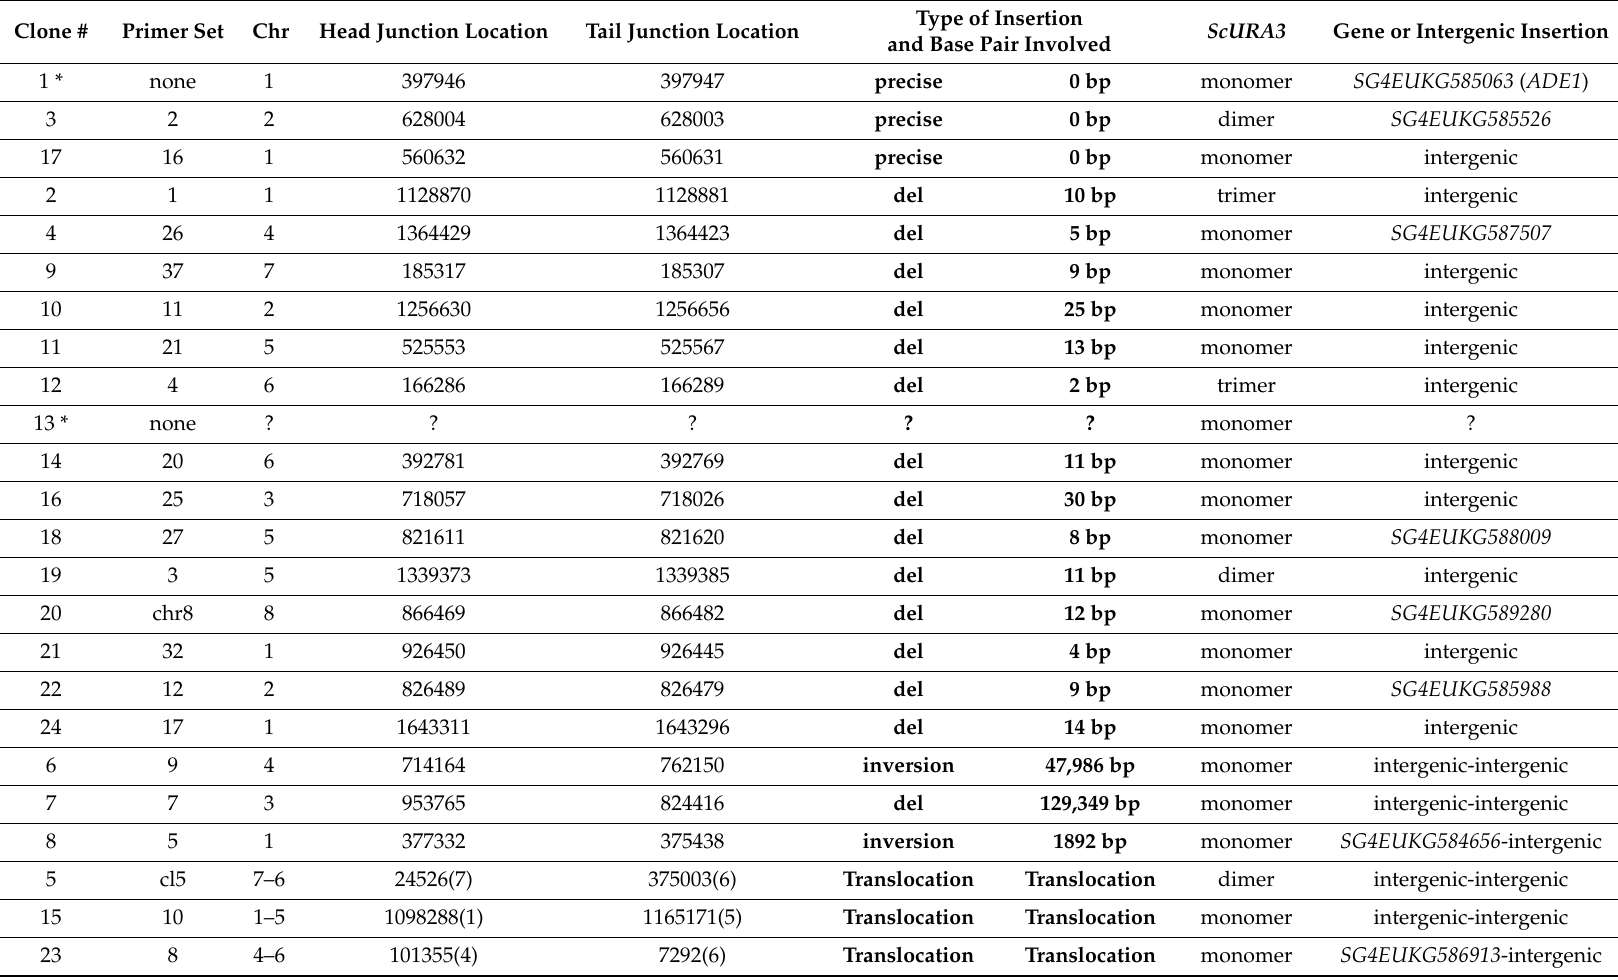
Table 1. Types of ScURA3 insertion events. The asterisk next to clones 1 and 13 indicates incomplete information (see text). Chr: Chromosome. #: number (see text). ?: